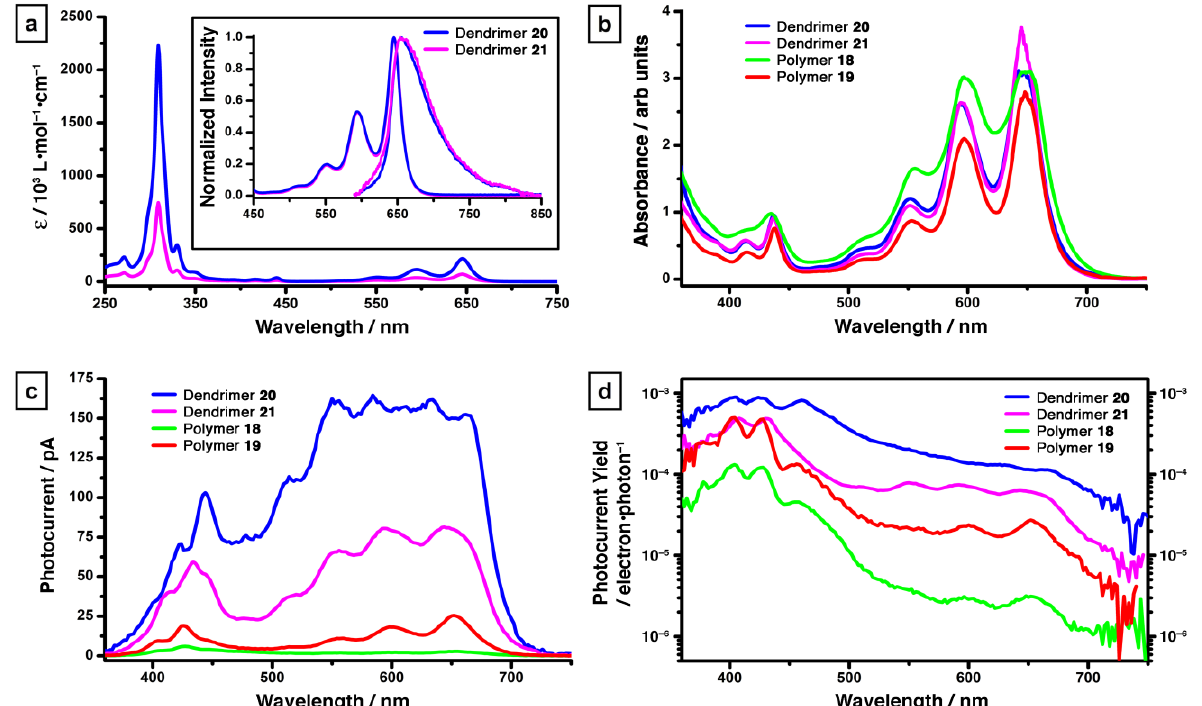
Figure 3. (a) Solution-state absorption and emission spectra for dendrimers 20–21 (in CH Cl ). Plots of (b) UV–vis absorption spectra, (c) photoconductive response, and (d) 2 2 photoconductive yield of thin film devices of dendrimers 20 – 21 and polymers 18–19 . Figure adapted with permission from reference [37]. Copyright 2009 American